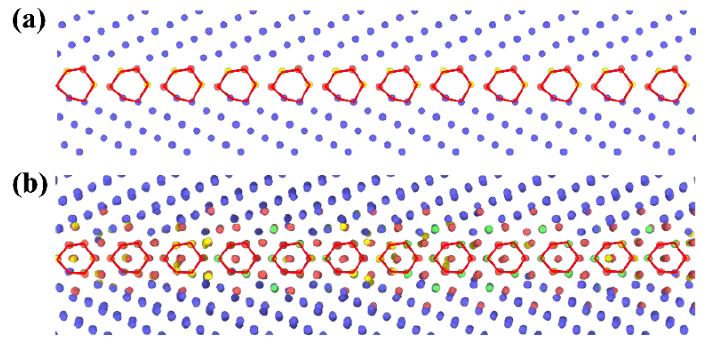
Figure 5. The GB microstructures of Σ11{332}{332} for ( a ) W at 0 and ( b ) W at 2400 K. The structure units of the GBs are highlighted by red polygons. The atoms arranged in body-centered cubic (BCC), face-centered cubic (FCC), hexagonal close-packed (HCP), and other patterns are colored by bule, green, red, and yellow, respectively.